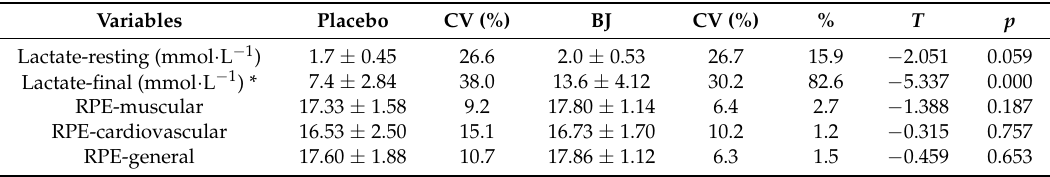
according to the experimental conditions (beetroot juice or placebo